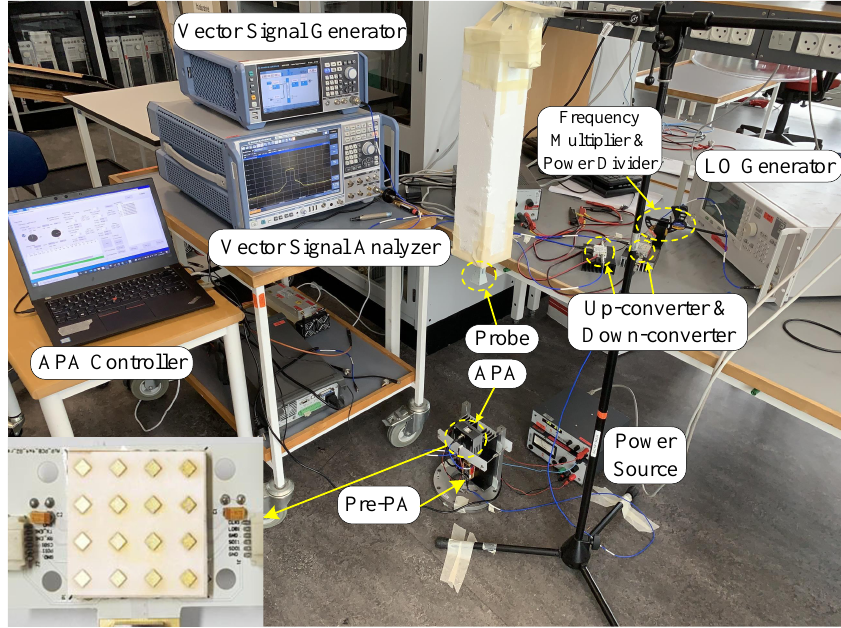
Figure 8. The LAB picture of the measurement